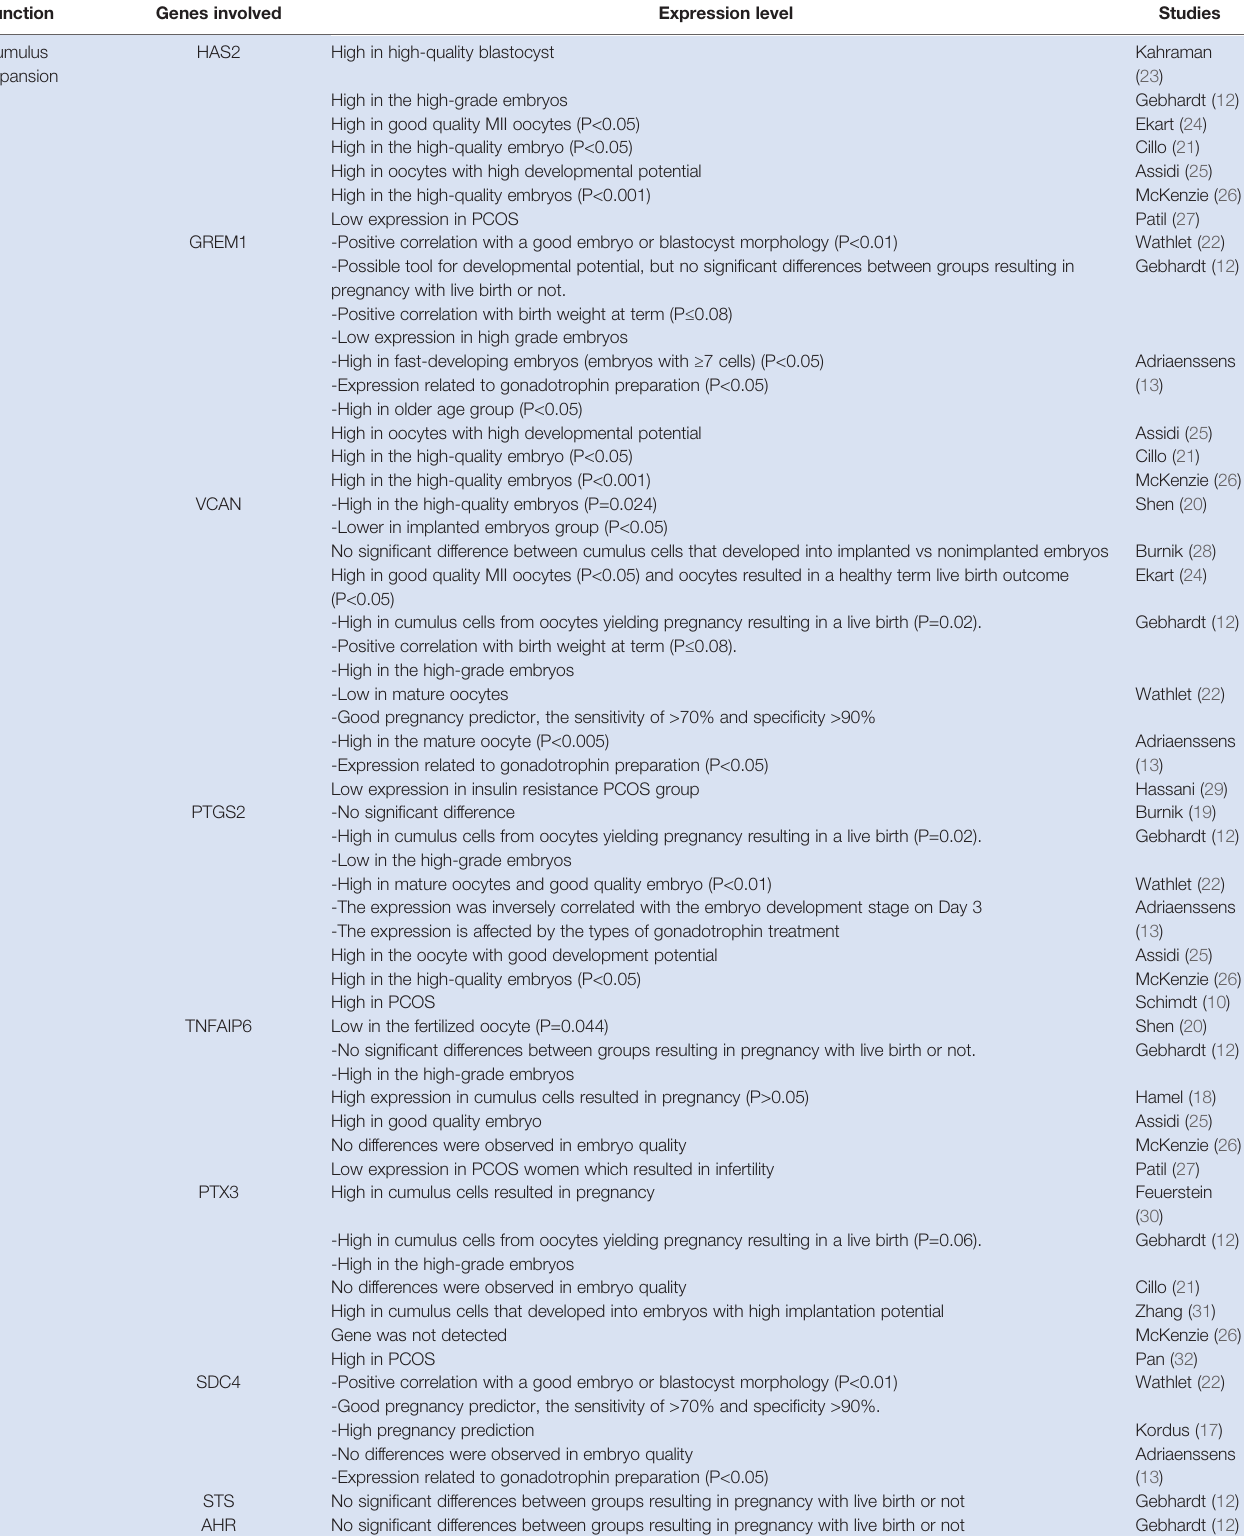
TABLE 2 | Cumulus gene expression according to the physiological function and its correlation with the quality of embryo.